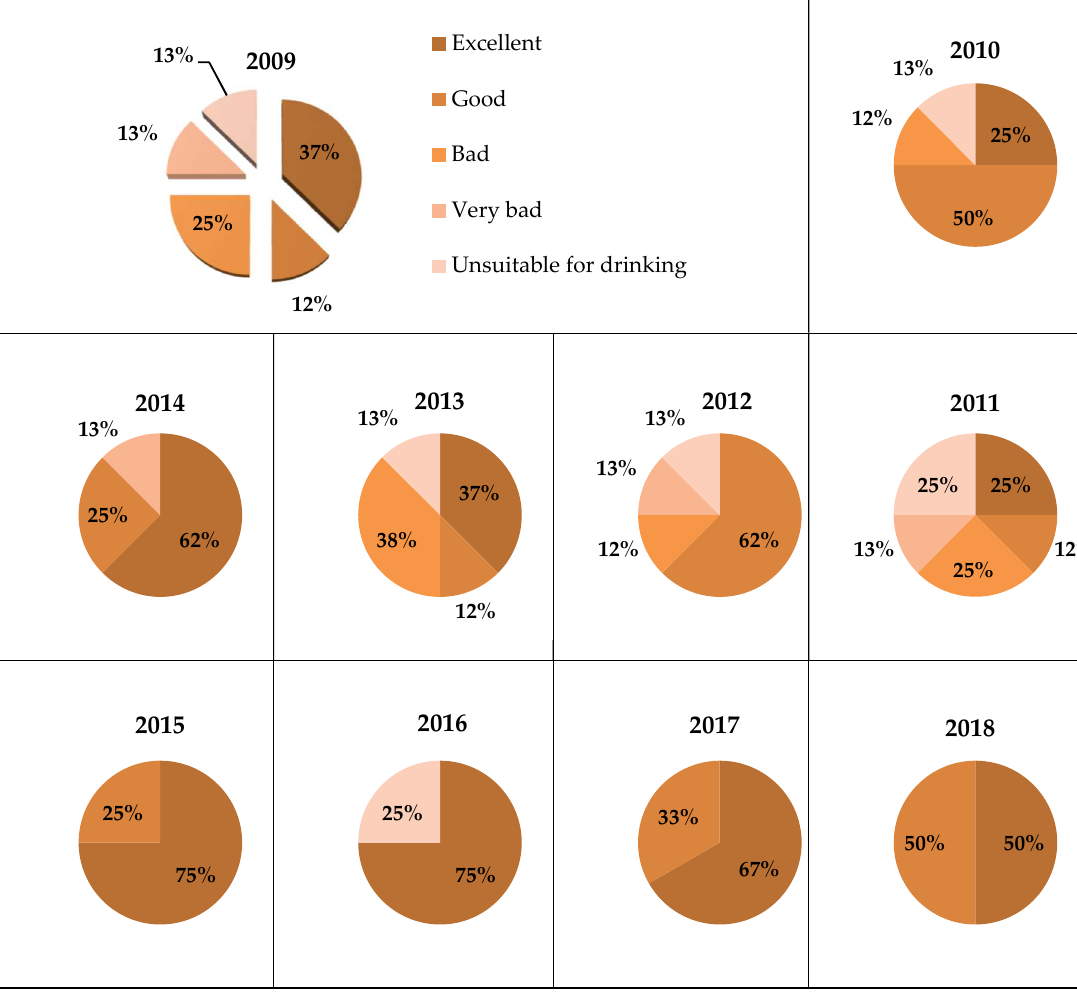
Figure 8. Percentage of groundwater quality at eight wells based on GWQI in the wet season, during 2009–2018.